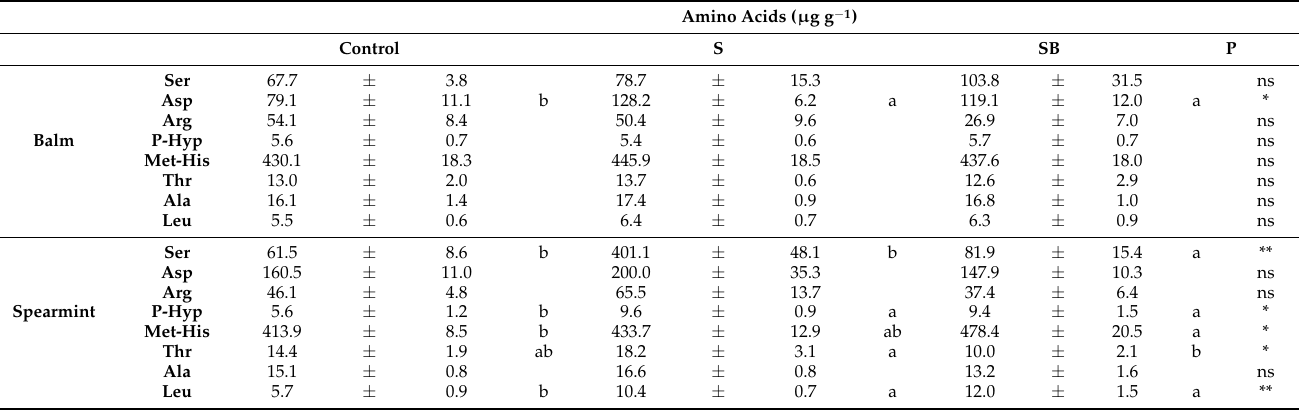
Table 4. Concentration of amino acids in leaves of balm and spearmint plants irrigated with water from different sources at 15th day. Values are mean ± S.E. of six